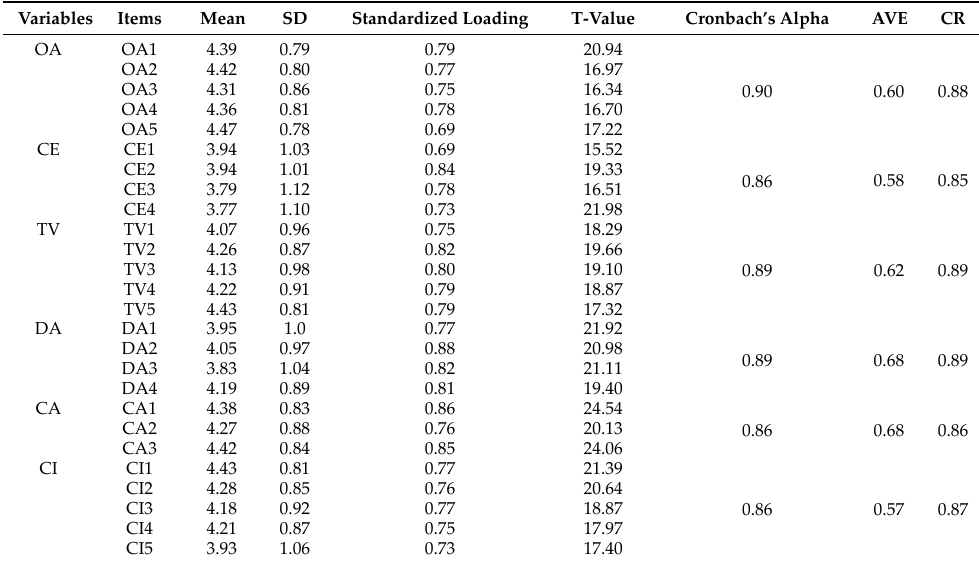
Table 3. Means, reliability, and convergent validity of items.